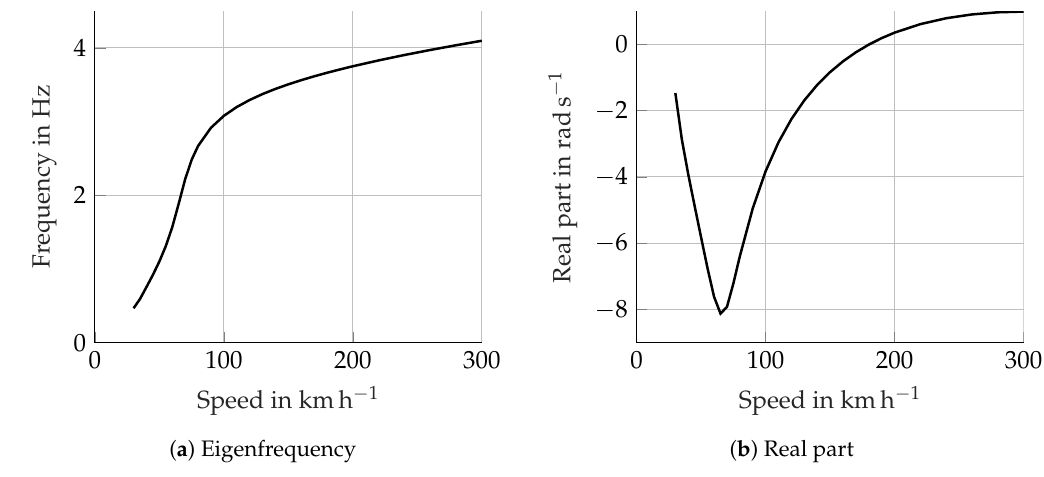
Figure 9. Weave eigenfrequency and damping as a speed function.